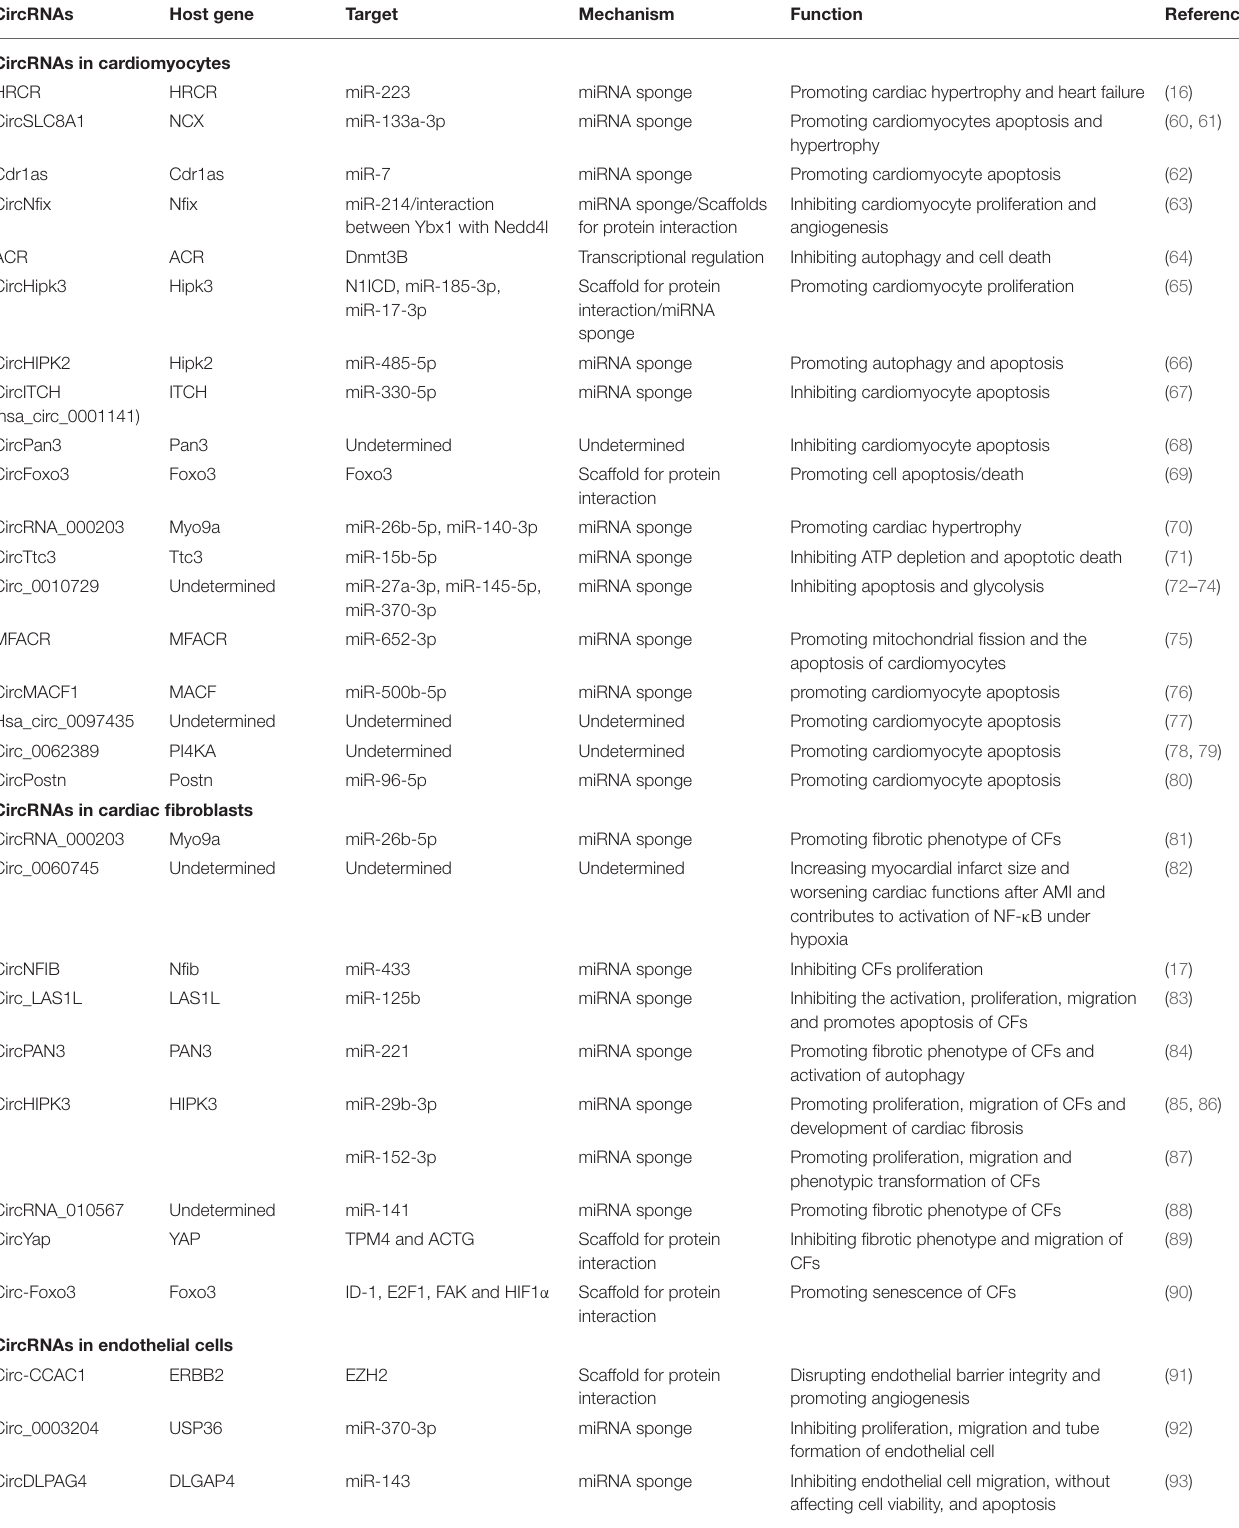
TABLE 1 | A list of reported regulatory circRNAs in cardiac remodeling.